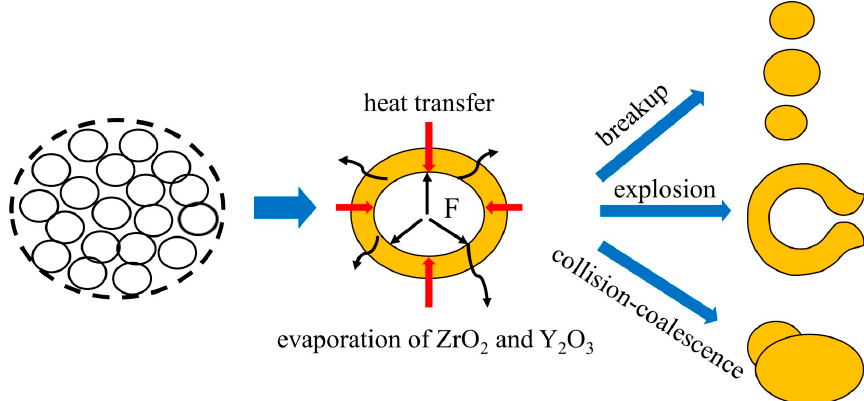
Figure 10. Morphologies of C-AS particles: ( a , b ) surface morphologies; ( c , d ) cross-sectional Figure 10. morphologies.